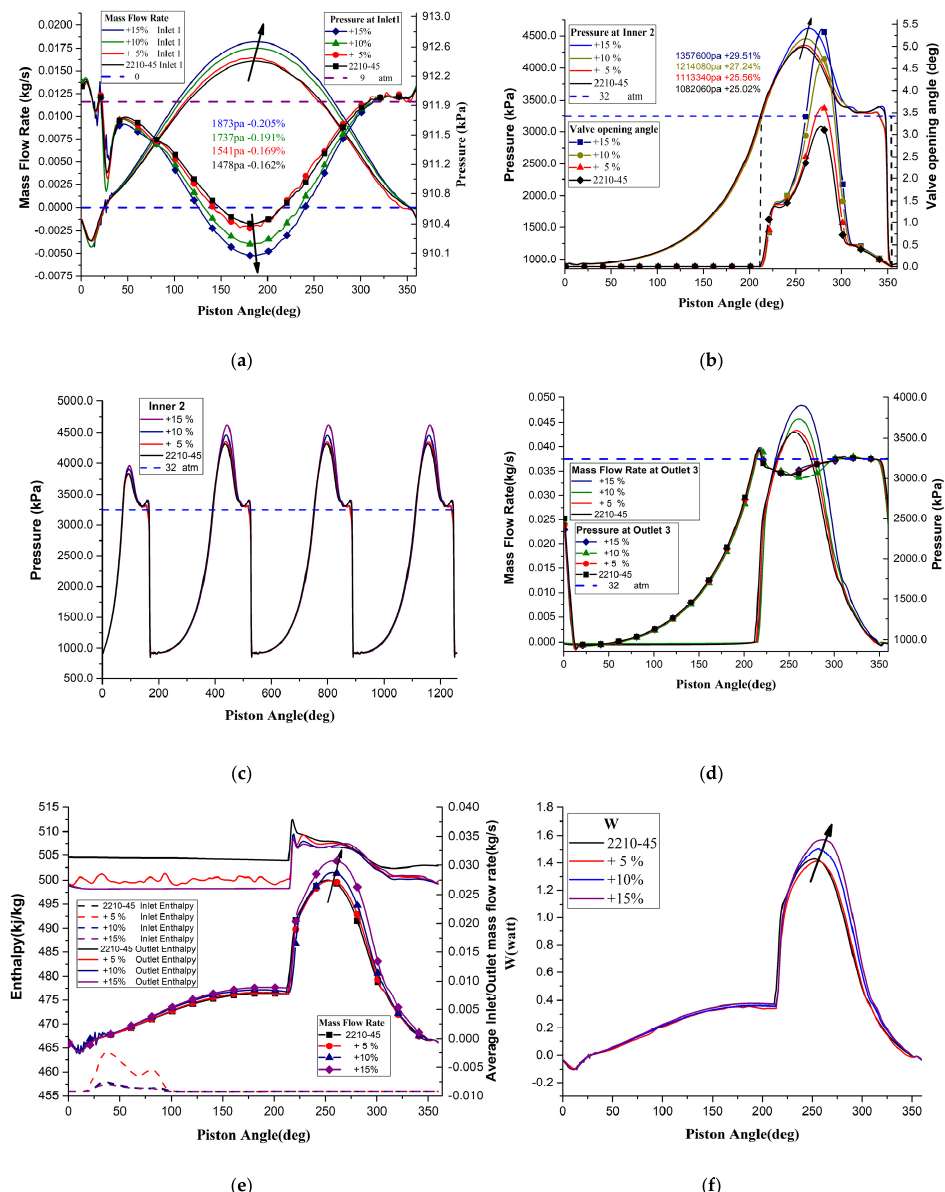
Figure 12. Physical properties of different volumes by increasing original one up to 15% in 5% increment : ( a ) mass flow rate and pressure at Inlet 1 ( b ) pressure of compression chamber at Inner 2 and opening angle of reed valve ( c ) pressure variation at Inner 2 during a serial cycles ( d ) discharge mass flow rate and pressure at Outlet 3 ( e ) enthalpy at inlet/outlet and average mass flow rate ( f ) instantaneous rate of work done on the refrigerant.